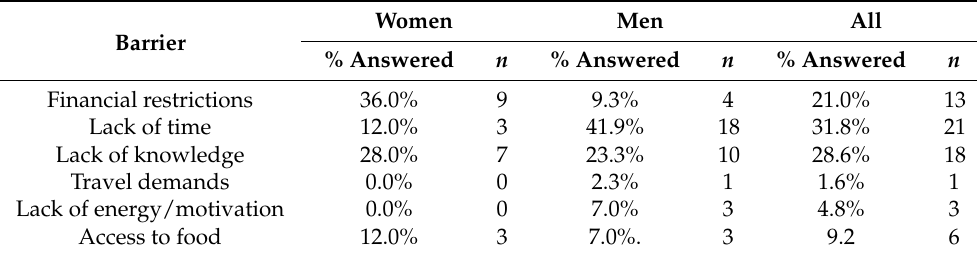
Table 4. Frequency of responses for nutritional